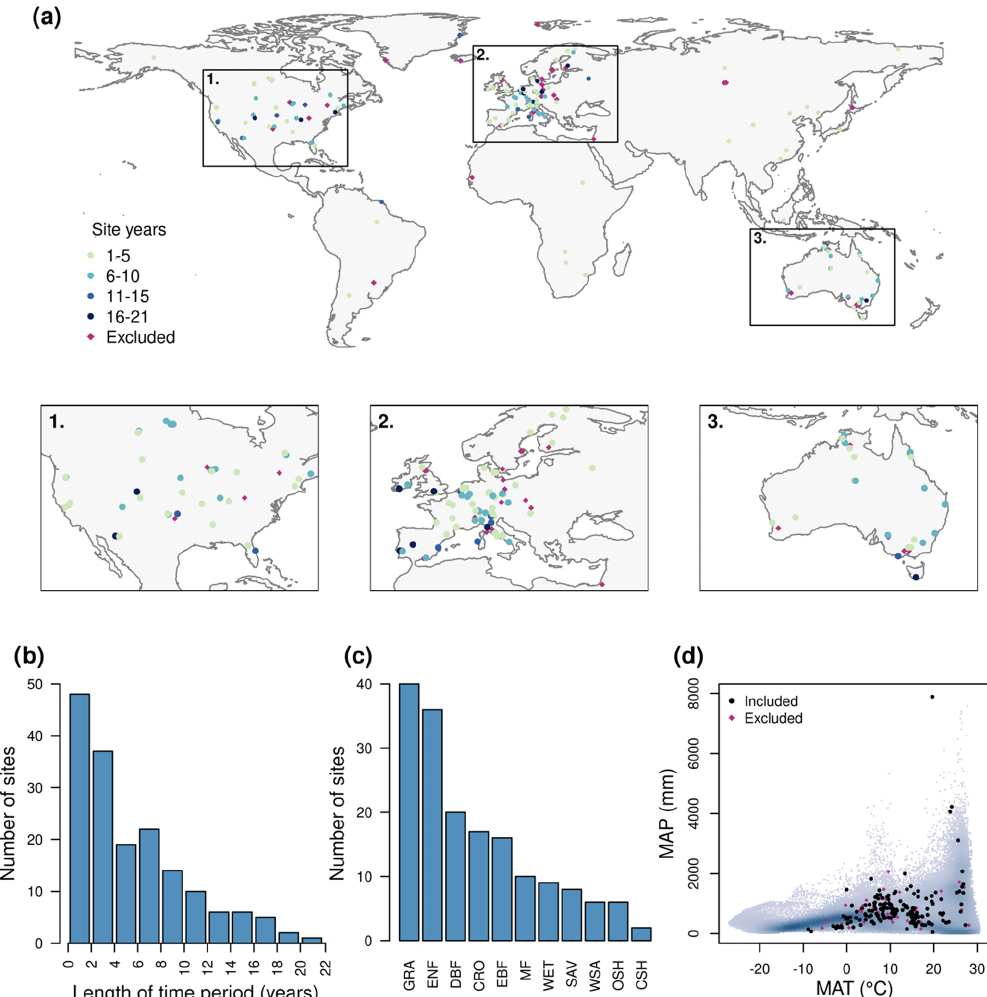
Figure 3. Selected and excluded sites. (a) A map of selected sites including the length of data period and excluded sites, (b) a histogram of record length for selected sites, (c) number of selected sites per IGBP vegetation class, and (d) the distribution of selected and excluded sites within the global envelope of mean annual temperature (MAT) and mean annual precipitation